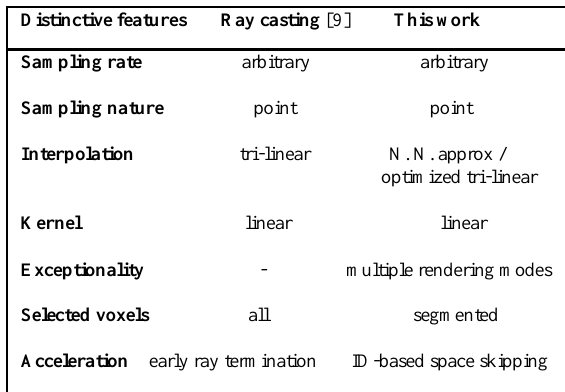
Table 1. Comparison between ray casting and this